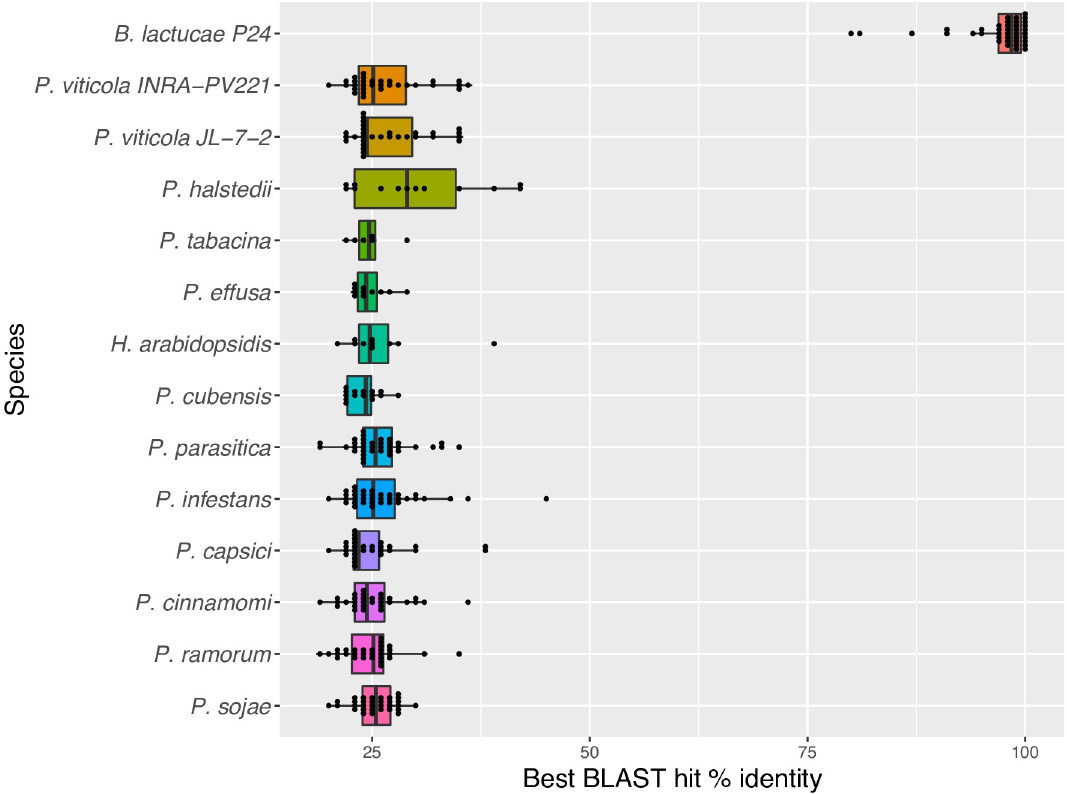
Fig 4. Lineage specificity of predicted secreted WY effectors from B . lactucae . Secreted WY proteins predicted in isolate SF5 of B . lactucae were used as a query for BLASTp against other oomycete translated ORFs. Isolate C82P24 was queried for B . lactucae . The best BLAST hit percent identity for each protein was calculated. The box plot shows the distribution of the best BLAST hits per B . lactucae WY protein from each species, with each dot representing an individual data point. No hits were observed to Albugo laibachii , Saprolegnia parasitica , or Pythium ultimum